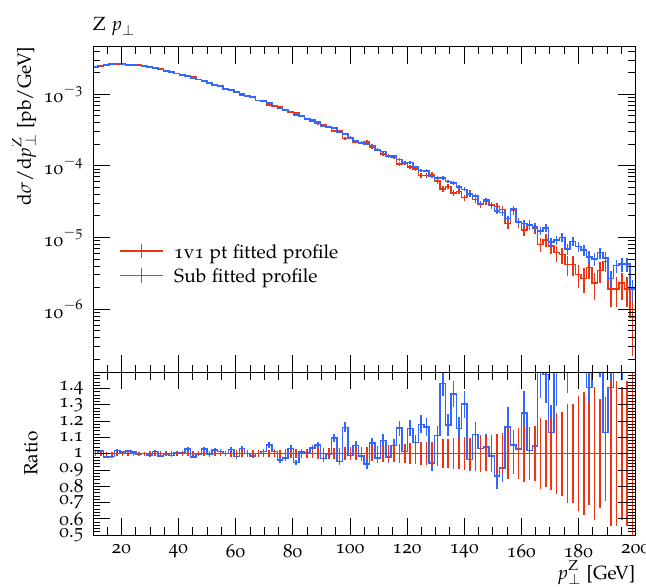
Figure 15 . Transverse momenta of the Z 0 bosons as produced by the 1v1,pt and subtraction terms for a decreasing Gaussian form of g ( k ? ; y ). The 1v1,pt setup is the reference in the ratio plot and is de(cid:12)ned as in section 3.3. The histograms are not normalised to unity. with z = b 0 p ? =(cid:23) . The result of the (cid:12)t gives the coe(cid:14)cients 7 (cid:12) 0 = 3 : 58, (cid:11) 0 = 1 : 16, (cid:13) = 1 :